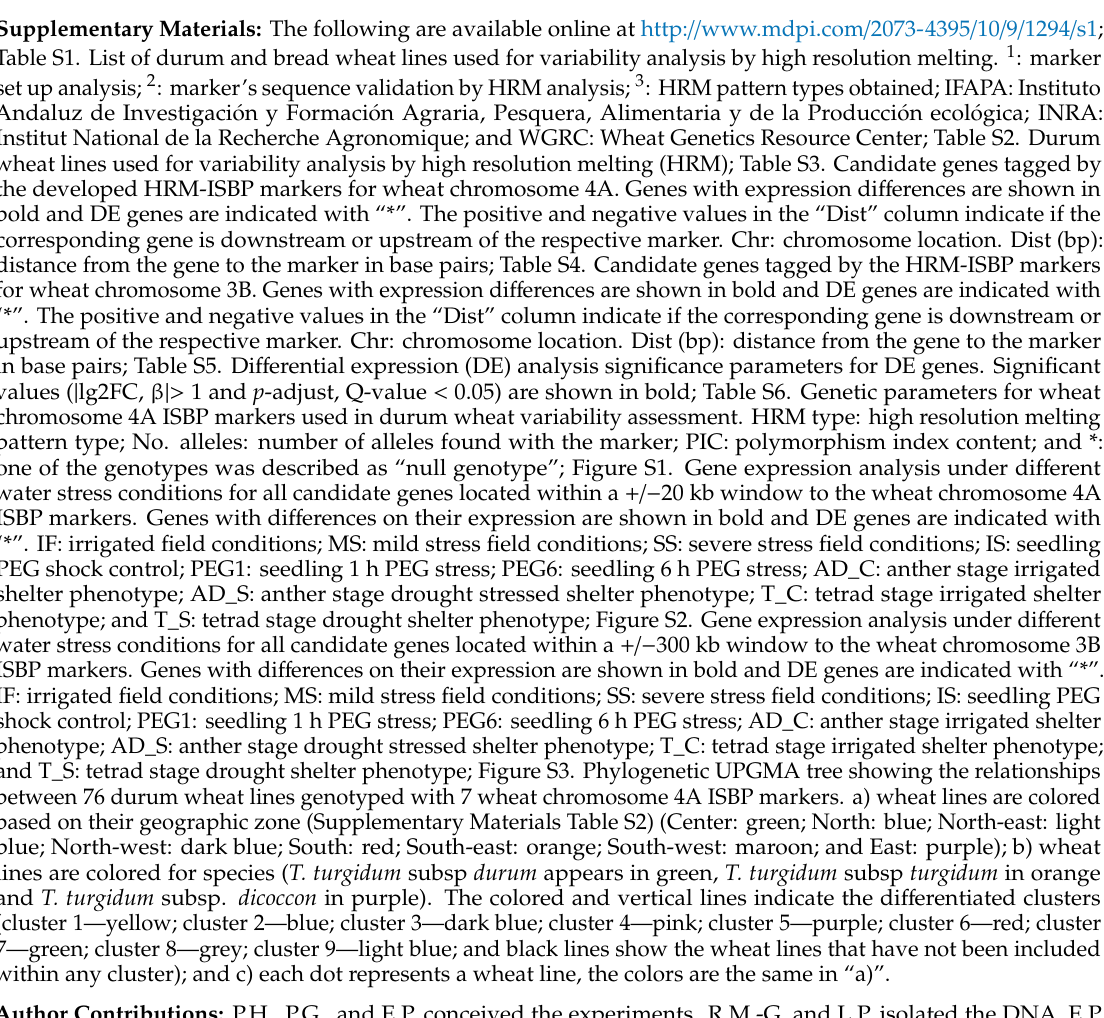
Table S1. List of durum and bread wheat lines used for variability analysis by high resolution melting. 1 : marker set up analysis; 2 : marker’s sequence validation by HRM analysis; 3 : HRM pattern types obtained; IFAPA: Instituto Andaluz de Investigaci ó n y Formaci ó n Agraria, Pesquera, Alimentaria y de la Producci ó n ecol ó gica; INRA: Institut National de la Recherche Agronomique; and WGRC: Wheat Genetics Resource Center; Table S2. Durum wheat lines used for variability analysis by high resolution melting (HRM); Table S3. Candidate genes tagged by the developed HRM-ISBP markers for wheat chromosome 4A. Genes with expression di ff erences are shown in bold and DE genes are indicated with “*”. The positive and negative values in the “Dist” column indicate if the corresponding gene is downstream or upstream of the respective marker. Chr: chromosome location. Dist (bp): distance from the gene to the marker in base pairs; Table S4. Candidate genes tagged by the HRM-ISBP markers for wheat chromosome 3B. Genes with expression di ff erences are shown in bold and DE genes are indicated with “*”. The positive and negative values in the “Dist” column indicate if the corresponding gene is downstream or upstream of the respective marker. Chr: chromosome location. Dist (bp): distance from the gene to the marker in base pairs; Table S5. Di ff erential expression (DE) analysis significance parameters for DE genes. Significant values ( | lg2FC, β |> 1 and p -adjust, Q-value < 0.05) are shown in bold; Table S6. Genetic parameters for wheat chromosome 4A ISBP markers used in durum wheat variability assessment. HRM type: high resolution melting pattern type; No. alleles: number of alleles found with the marker; PIC: polymorphism index content; and *: one of the genotypes was described as “null genotype”; Figure S1. Gene expression analysis under di ff erent water stress conditions for all candidate genes located within a +/ − 20 kb window to the wheat chromosome 4A ISBP markers. Genes with di ff erences on their expression are shown in bold and DE genes are indicated with “*”. IF: irrigated field conditions; MS: mild stress field conditions; SS: severe stress field conditions; IS: seedling PEG shock control; PEG1: seedling 1 h PEG stress; PEG6: seedling 6 h PEG stress; AD_C: anther stage irrigated phenotype; and T_S: tetrad stage drought shelter phenotype; Figure S2. Gene expression analysis under di ff